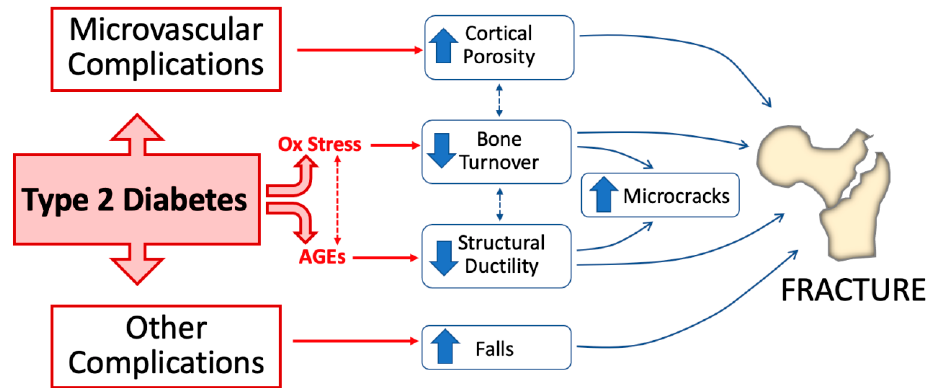
Figure 1. Pathophysiological mechanisms of bone fragility in type 2 diabetes. Alteration of glucose homeostasis in type 2 diabetes (T2D) leads to the accumulation of increased advanced glycation end-products (AGEs) in bone and enhances oxidative stress. Both of these conditions directly impact bone health by decreasing bone turnover and impairing structural bone ductility. Microvascular disease and other complications (e.g., neuropathy, retinopathy, and nephropathy) concur in T2D-induced bone fragility by, respectively, increasing cortical bone porosity and increasing the risk of falls.